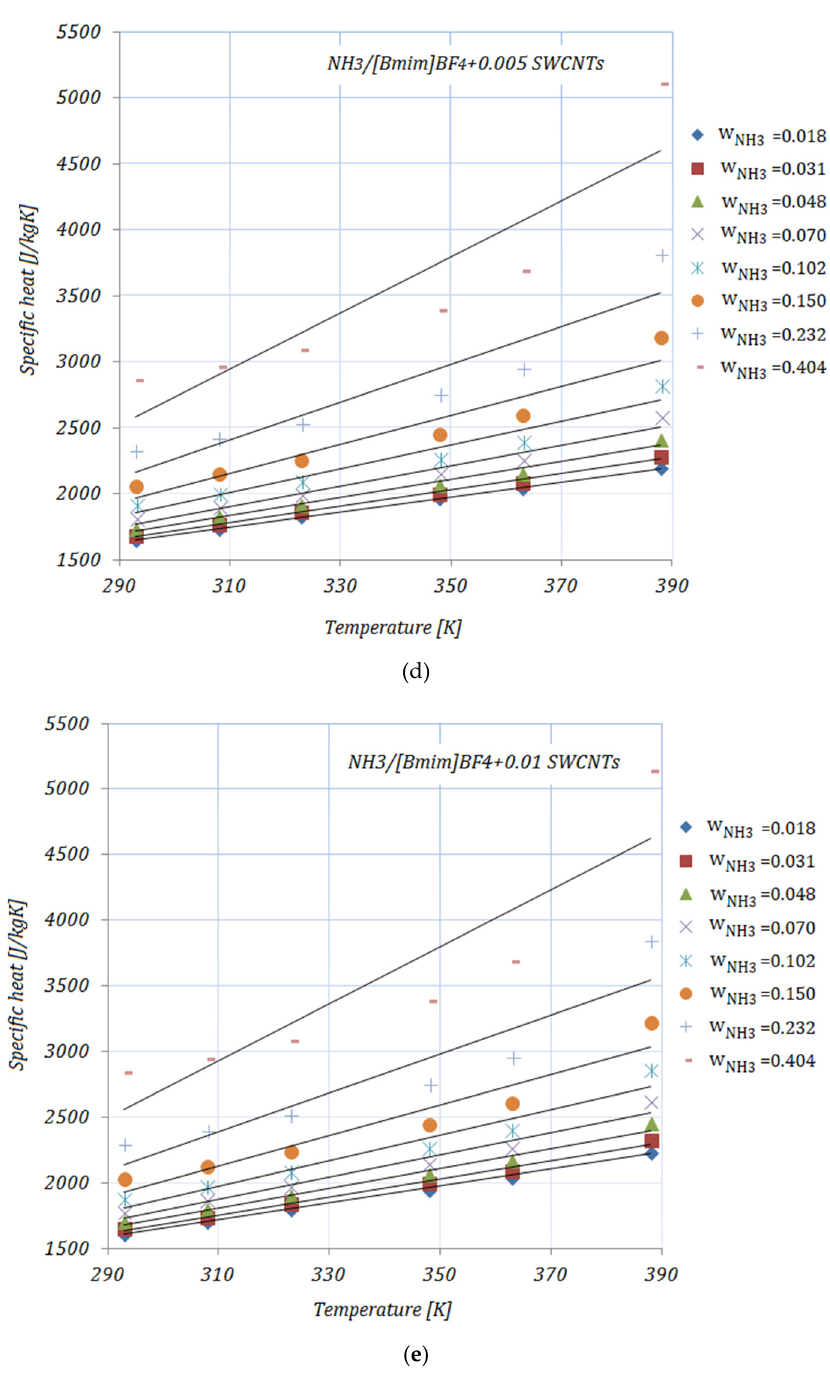
Figure 3. - Solution specific heat. Figure 3. Solution specific